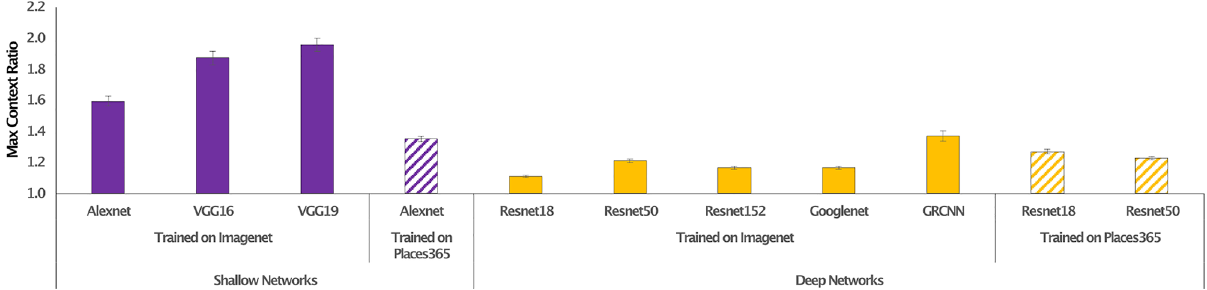
Figure 4. Contextual representations across a variety of networks. Maximum similarity ratio for ten CNN architectures trained on ImageNet (solid bars) and Place365 (striped bars) data sets. Each network tested demonstrated a significant effect of context (p’s < 2 × 10 –23 ). This effect is significantly greater in traditional (shallow) network architectures (purple bars) compared with more novel, deeper, network architectures (yellow